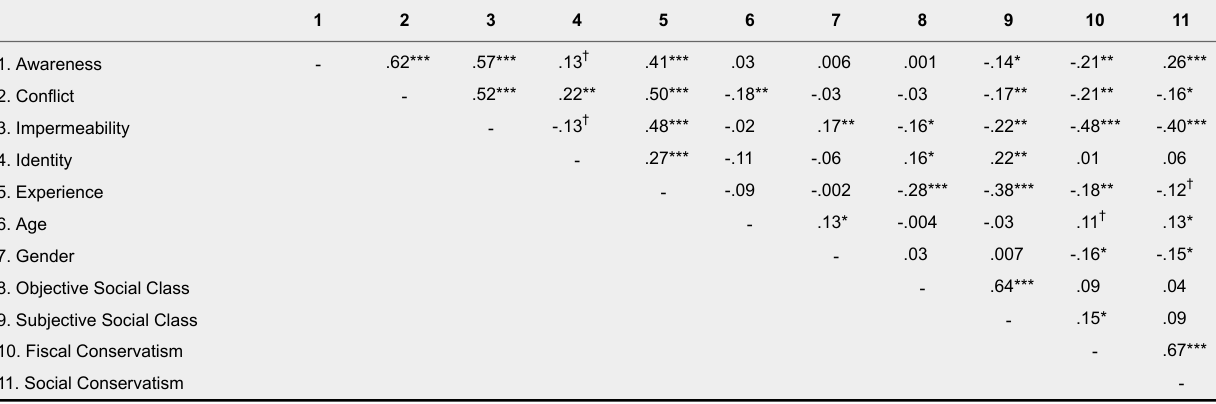
Full Correlation Table Between the Five Class Consciousness Factors and Demographic